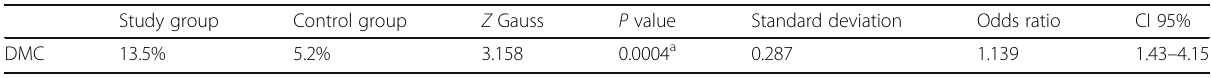
Table 2 Distribution of displacement of maxillary canine in subjects with tooth agenesis compared with control group Study group